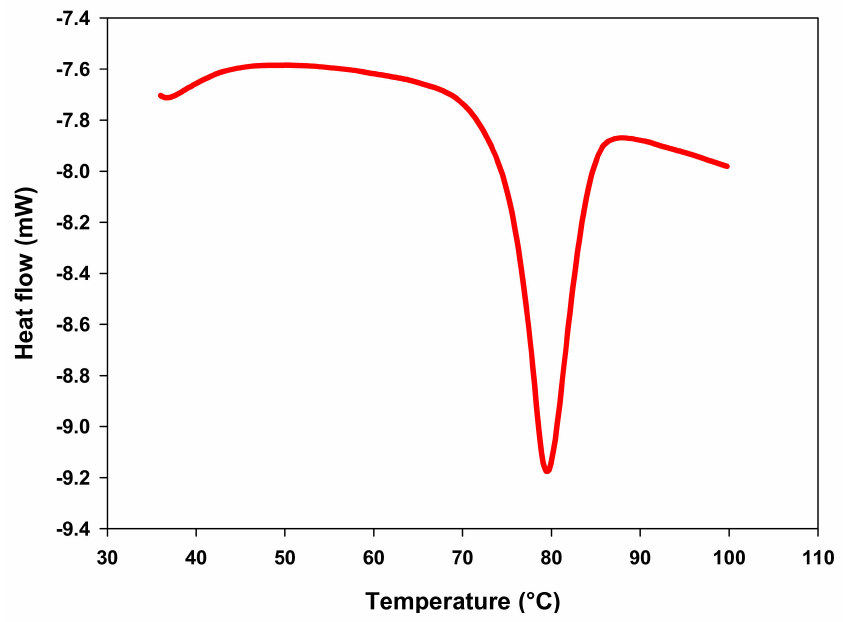
Figure 2. Differential scanning calorimetry (DSC) thermogram of Ceiba aesculifolia subsp. parvifolia tuber